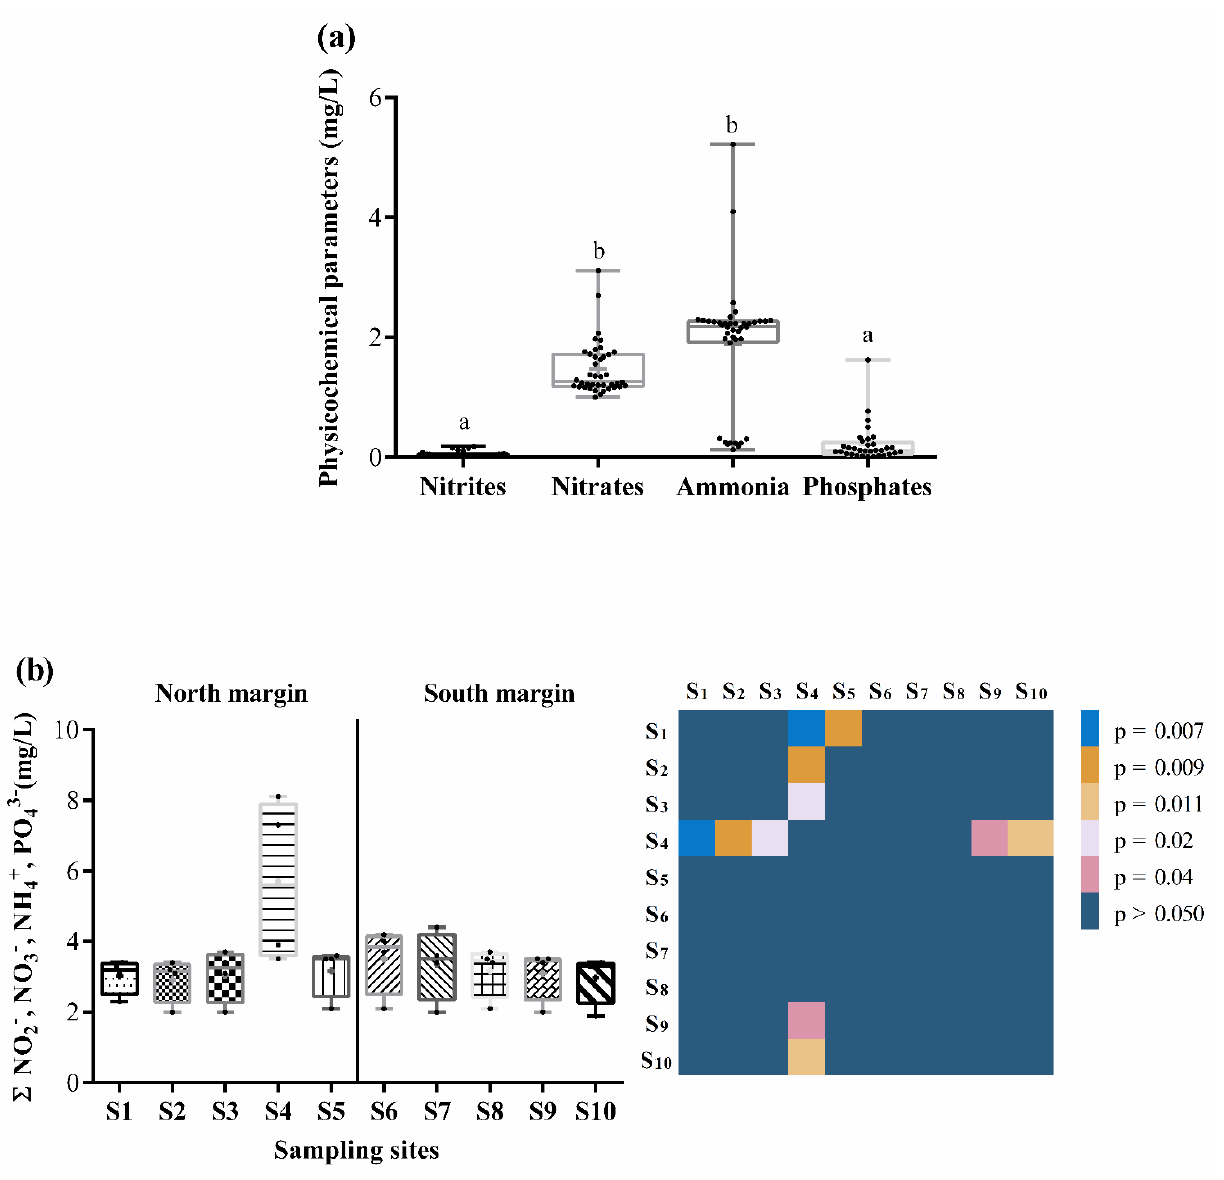
Figure 5. ( a ) Global levels (mg/L) of nitrites, nitrates, ammonia, and phosphates (n = 40). ( b ) Levels (mg/L) of ∑ nitrites, nitrates, ammonia, and phosphates per sampling site (n = 4). Data are expressed in boxplots with the minimum, median, maximum, average (+), and interquartile ranges Q1–Q3. Significant differences are reported in the colour chart. Different low case letters indicate significant differences amongst physiochemical parameters ( p < 0.05).